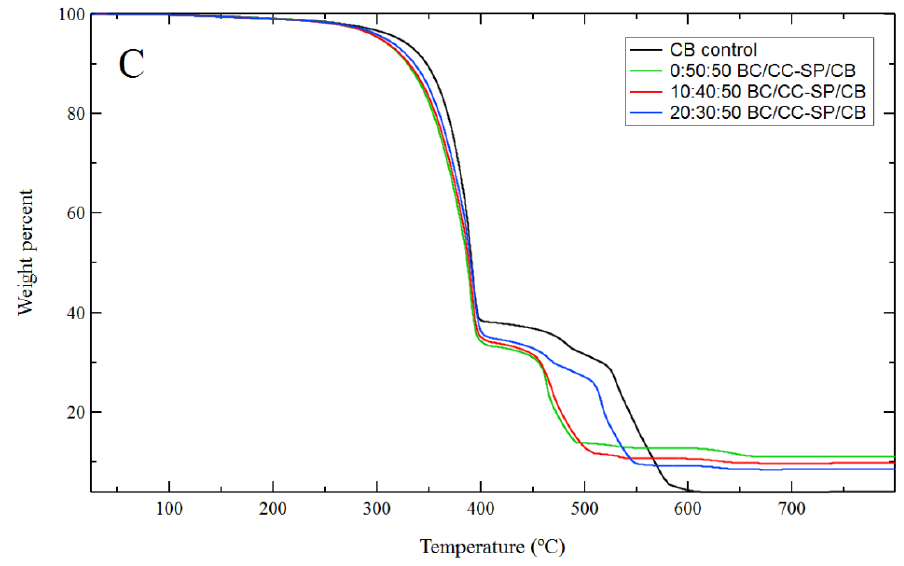
Figure 5. Thermal stability for: ( A ) 100% CB filled control and 100% silica-milled biochar, ( B ) com- posite samples with 20% CB and increasing BC:CC-SP ratio, and ( C ) composite samples with 50% CB and increasing BC:CC-SP ratio.